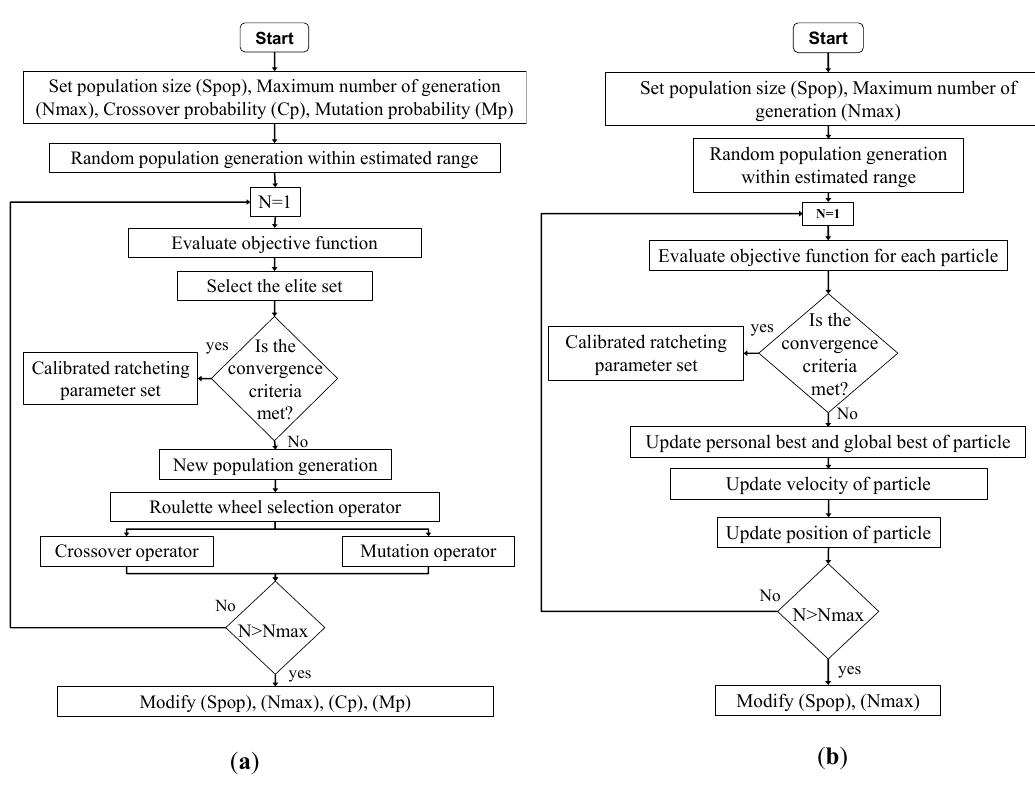
Figure 15. Overall optimization process flow diagram ( a ) GA ( b ) PSO.